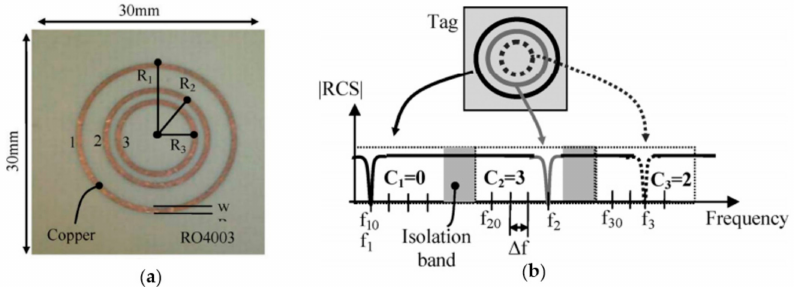
Figure 19. ( a ) Photograph of a chipless-RFID tag constituted by three circular rings and ( b ) the coding principle. Figure extracted from [80].